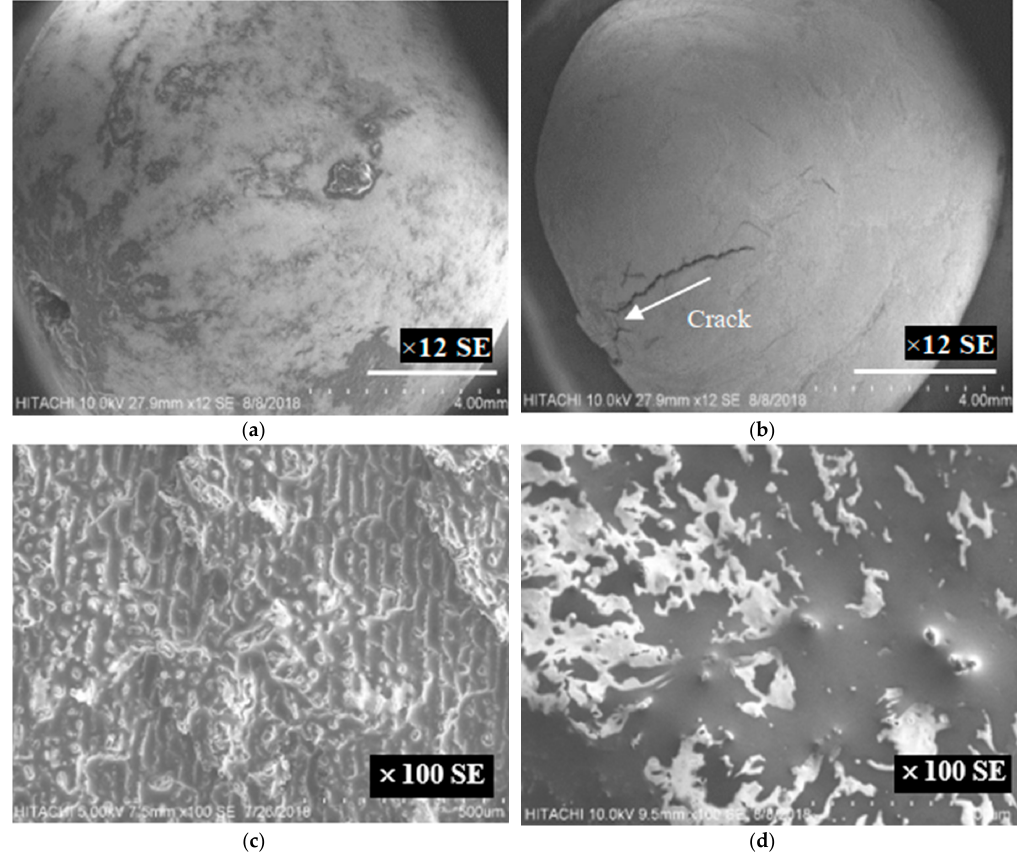
Figure 7. SEM of the surface of palm kernel before and after the drying process at 80 °C ( a ) 0.28 kg/kg, × 12 SE, ( b ) 0.07 kg/kg, × 12 SE, ( c ) 0.28 kg/kg, × 100 SE, and ( d ) 0.07 kg/kg, × 100